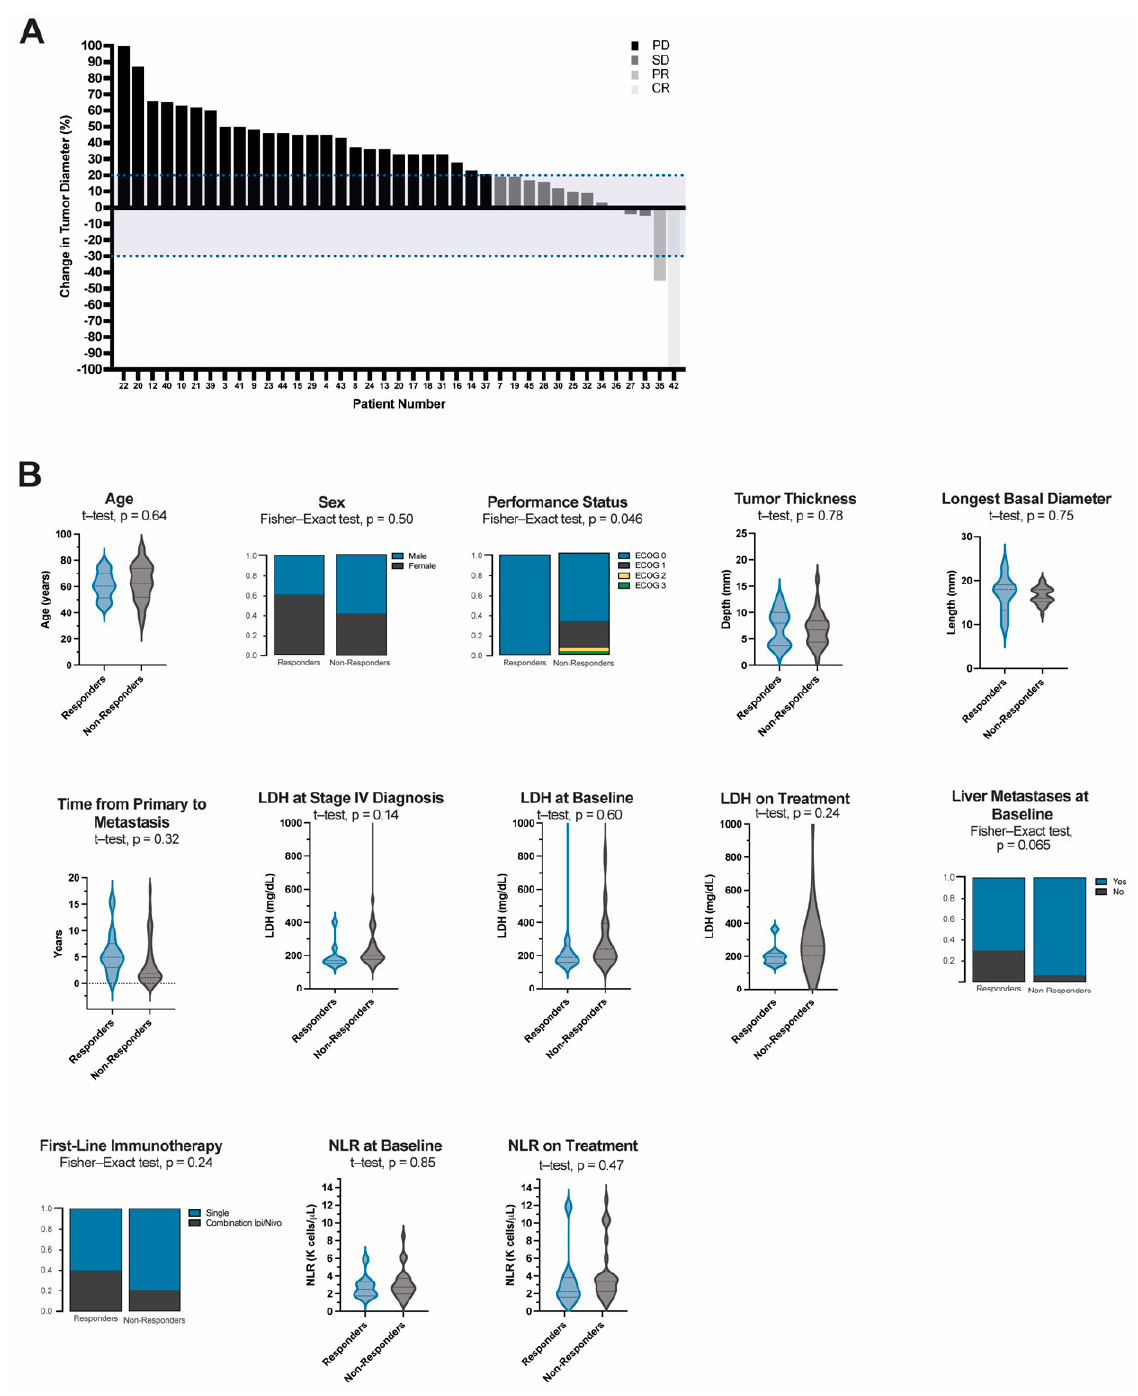
Figure 4. ( A ) Waterfall Plot of Tumor Response using RECIST criteria and ( B ) Demographic, hemato- logic, and treatment characteristics of responders compared to non-responders. Continuous variables are represented in violin plots with quartiles shown as dotted lines. Independent t -test was used to evaluate the difference in mean values between responders and non-responders. Categorical variables are represented by proportions of the analyzed variable within each group. Fisher-exact test was used for group comparisons. Responders ( n = 10) are comprised of patients who derived a clinical benefit from treatment, i.e., complete response (CR ( n = 1)), partial response (PR ( n = 1)), and those with stable disease (SD ( n = 8)). Non-responders ( n = 34) are comprised of all those who had progressive disease (PD). Objective response was determined using RECIST criteria. LDH = lactate dehydrogenase, NLR = neutrophil:lymphocyte